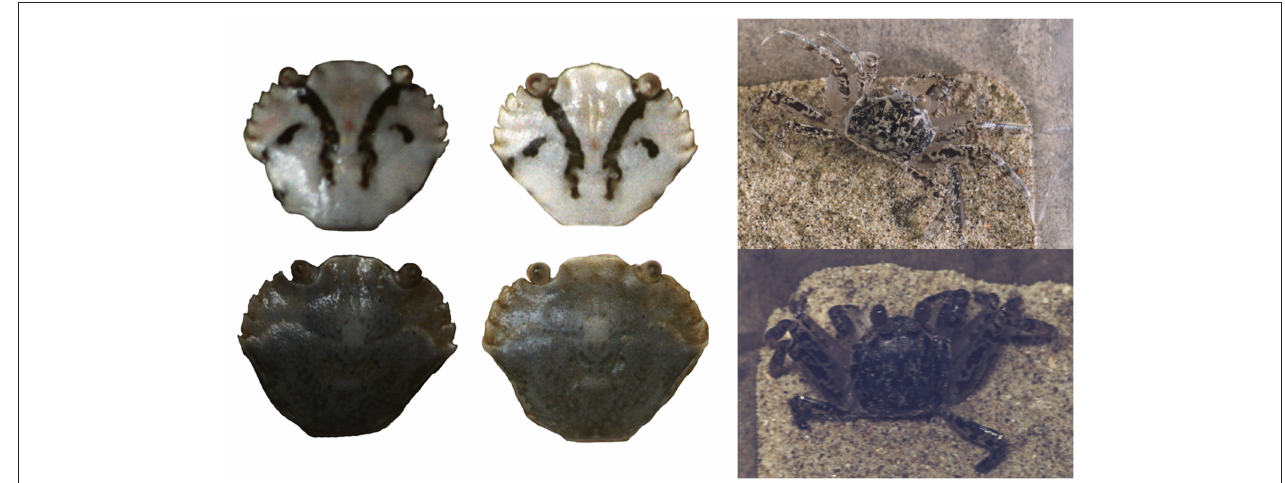
FIGURE 1 | Left image shows changes in the brightness of two shore crabs ( Carcinus maenas ) when placed on a black (left) and white (right) background for 2h. From Stevens et al. (2014a). Right image shows a horned ghost crab during the day with light yellow coloration (top), and at night with dark gray coloration